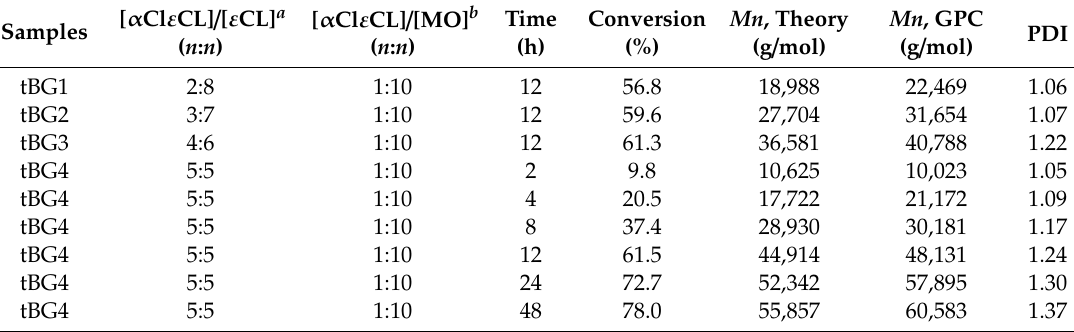
Figure 1. Gel permeation chromatography (GPC) trace of the copolymers. Table 1. Synthesis data of copolymers .